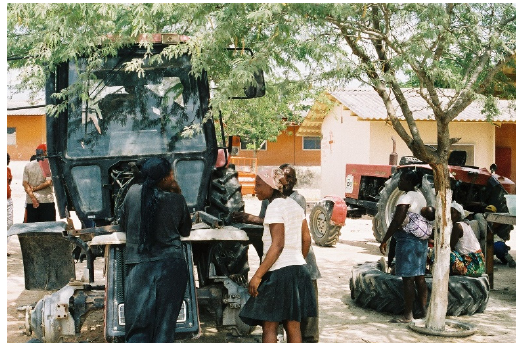
Figure 11. Public sector farm machinery services targeting smallholder farmers have usually been financial failures.